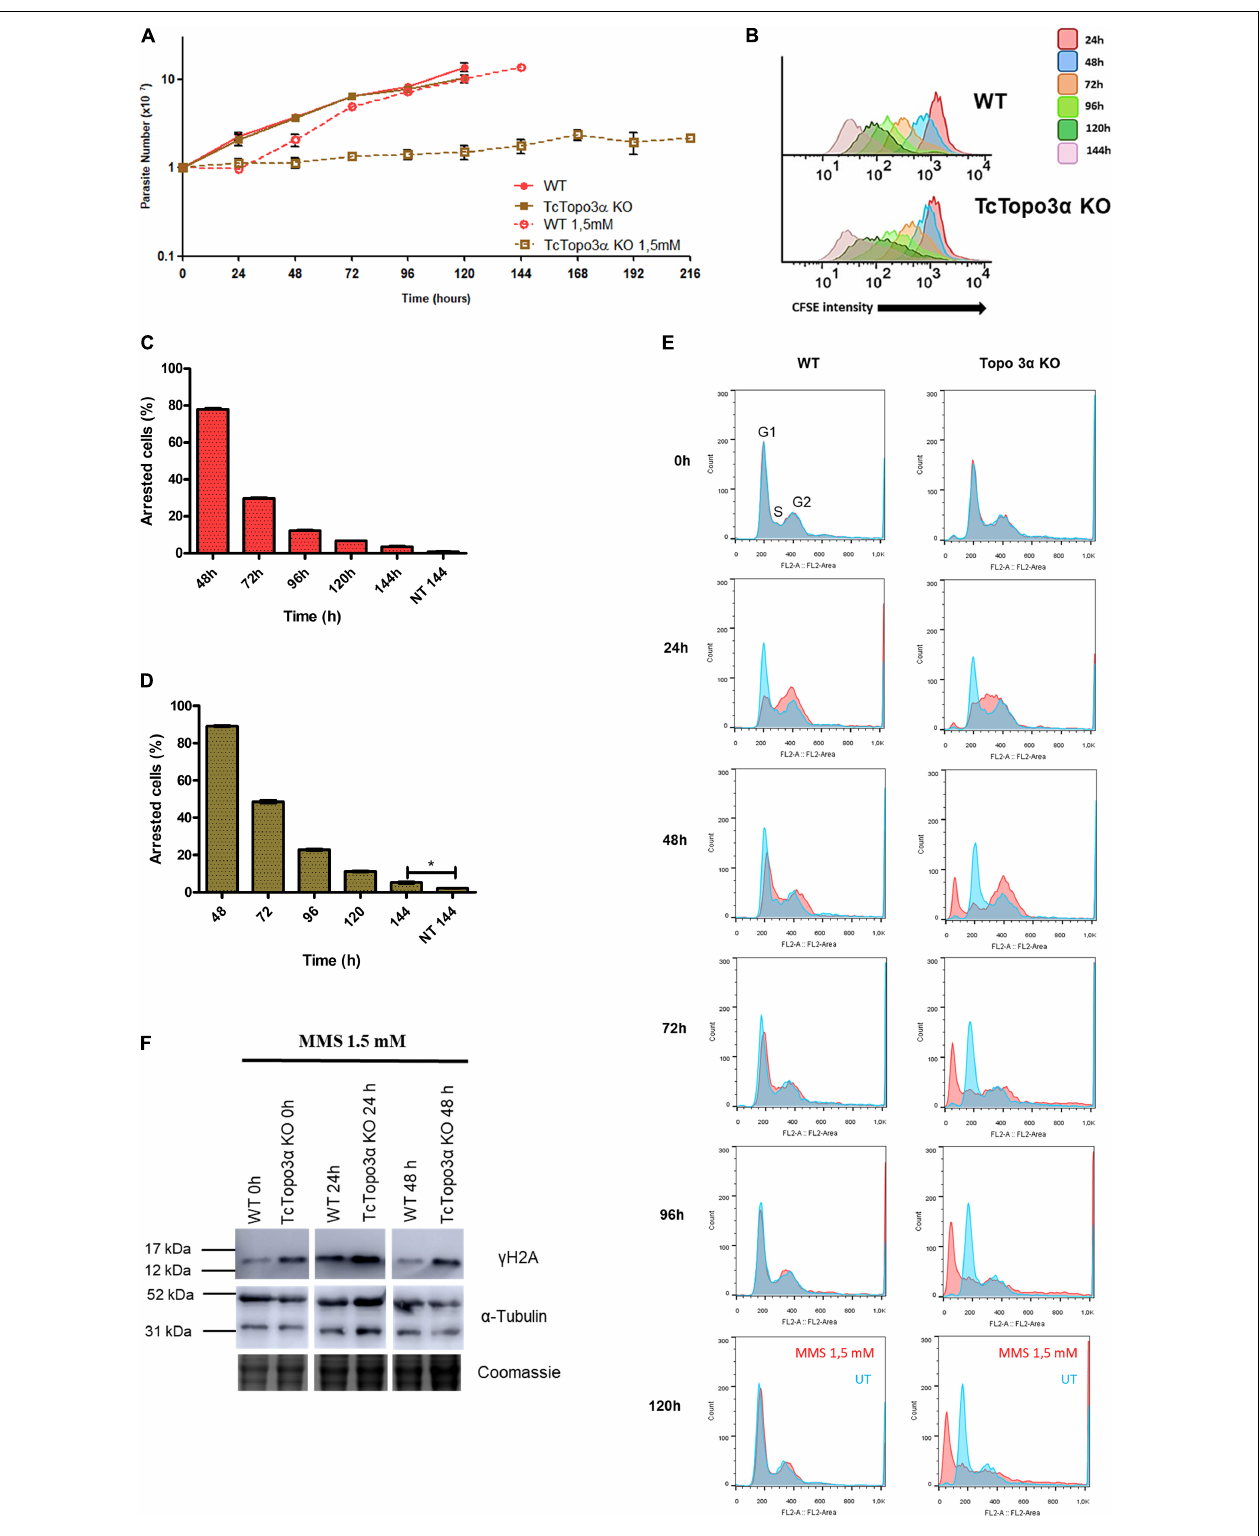
FIGURE 6 | The role of topoisomerase 3 α in the response to methyl methanesulfonate (MMS) treatment. (A) Growth curve after the treatment with 1.5 mM MMS for 1 h in PBS buffer. After the treatment, the cells were cultivated in fresh medium. The cells were counted every day using a cytometry chamber and vital dye